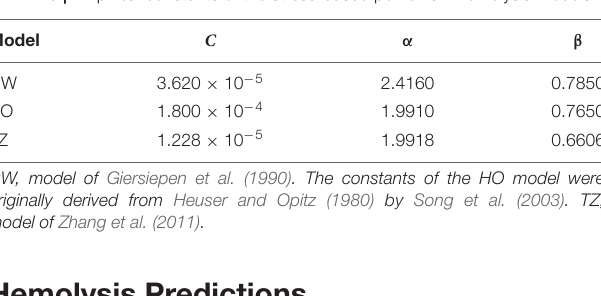
TABLE 3 | Empirical constants of the stress-based power-law hemolysis